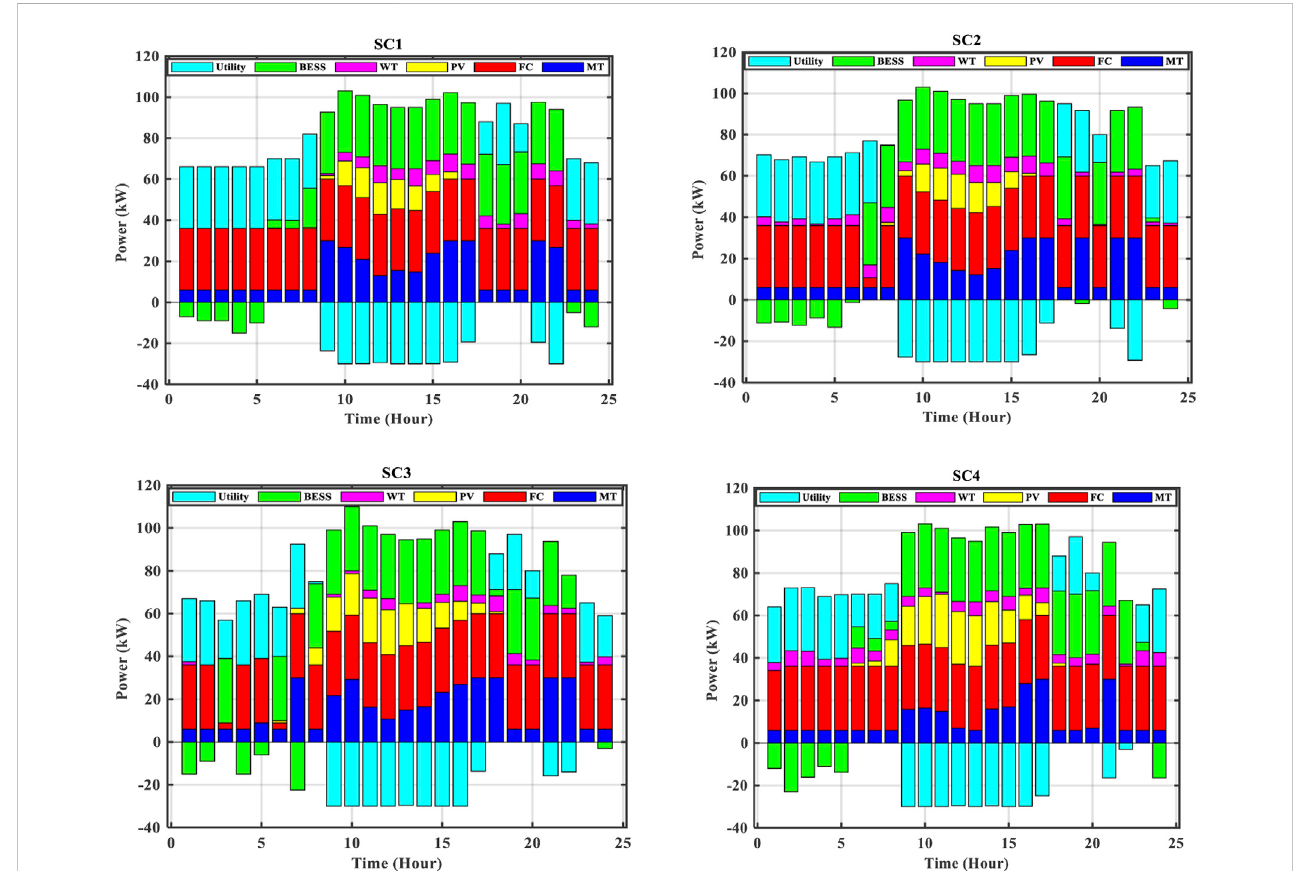
FIGURE 7 Case1 with 5% DSM, SC1, SC2, SC3,